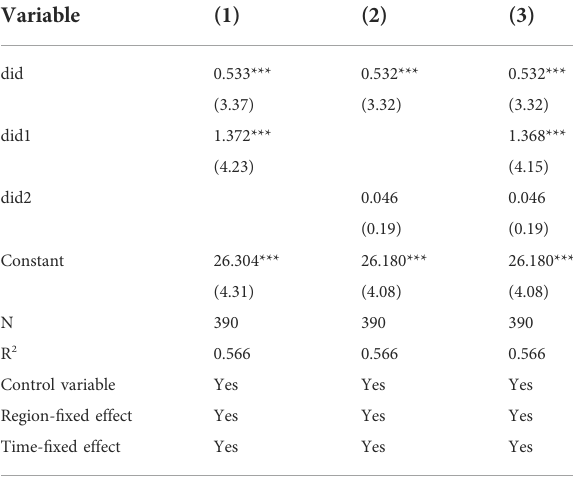
TABLE 5 Regression results of changing the timing of policy implementation.